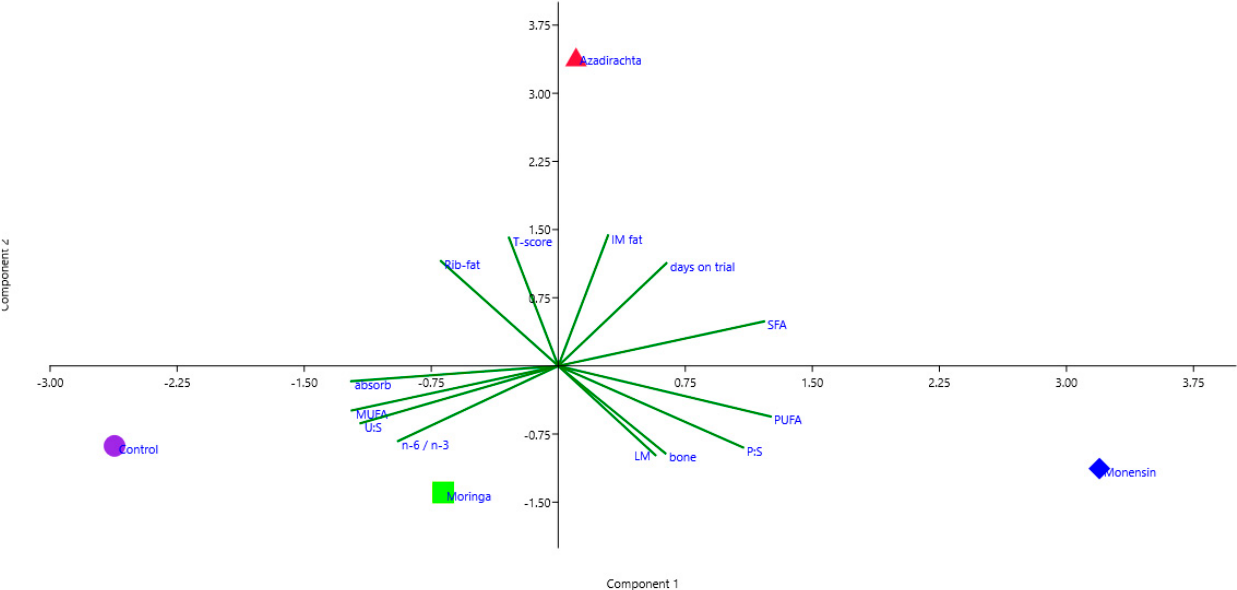
Figure 1. Projections of carcass and meat quality measurements on a plane defined by PC 1 (i.e., fatty acid composition component) and PC 2 (i.e., fat content component). Fat%: Rib-fat; carcass fat content t-scores: T-score); intramuscular fat%: IM fat; saturated fatty acids: SFA; PUFA:SFA—P:S; bone percentage: bone; meat%: LM; UFA:SFA—U:S; absorbance: absorb. Neem treatment: Aza- dirachta; monensin treatment: monensin; moringa treatment: moringa; negative control treatment: